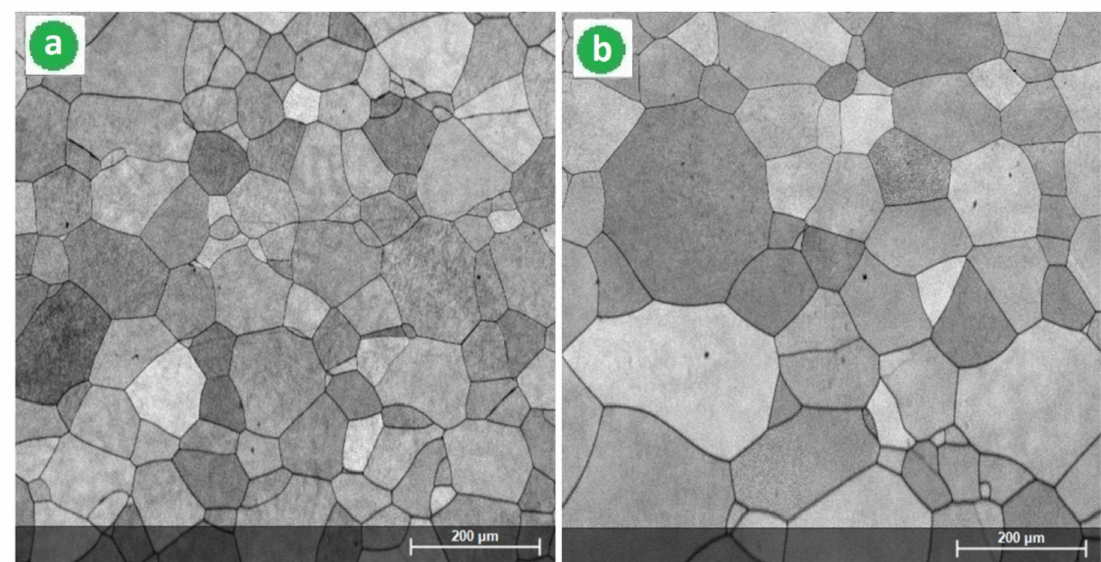
Figure 4. SEM-BSE images of the Ti-34.18Nb-7.6Zr-0.9Fe-0.16O alloy microstructures in the as-cast state ( a ) and after the homogenization treatment ( b ).